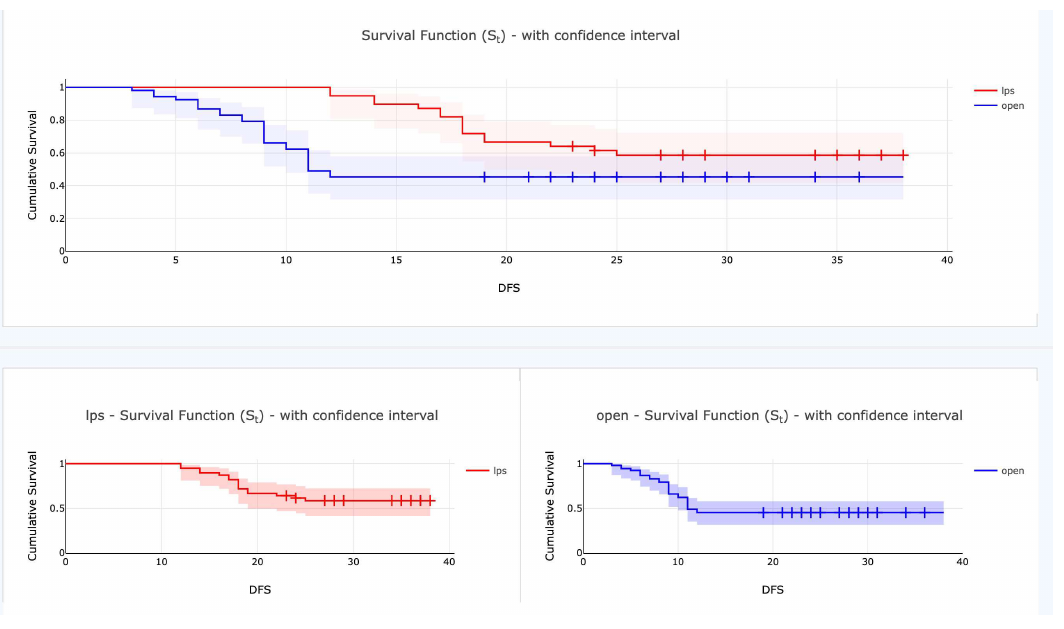
Fig.2 - Kaplan-Meier 3-yrs disease free survival curve according to surgical technique P=0.041 (log rank test). (Color version of figure is available online)